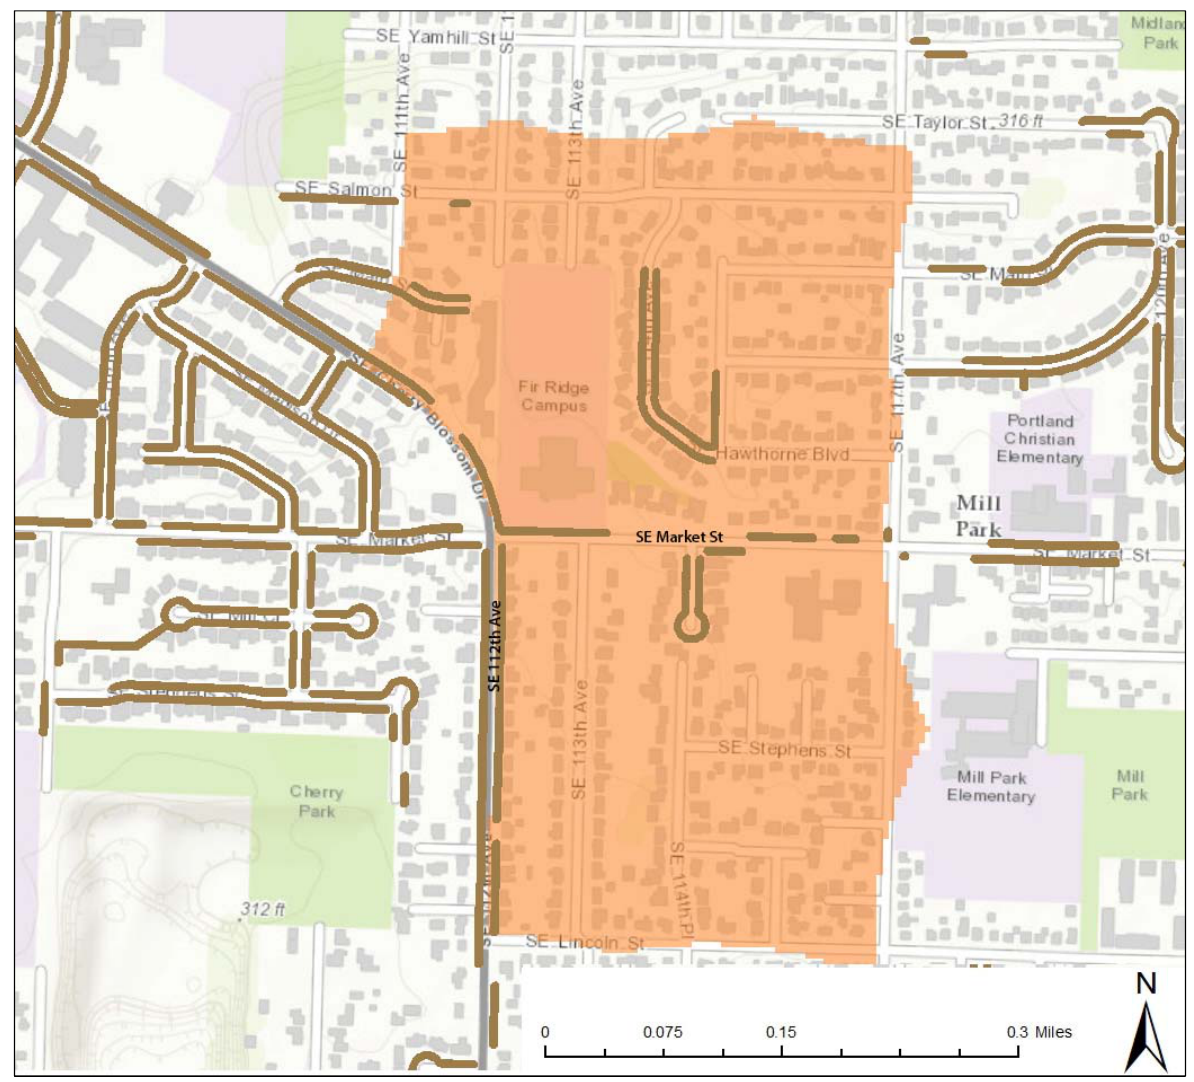
Figure 12. Highlighted Area in Southeast Portland. This area from SE 112th Avenue to SE 117th Avenue and SE Salmon Street to SE Lincoln Street contains Fir Ridge Campus, an alternative high